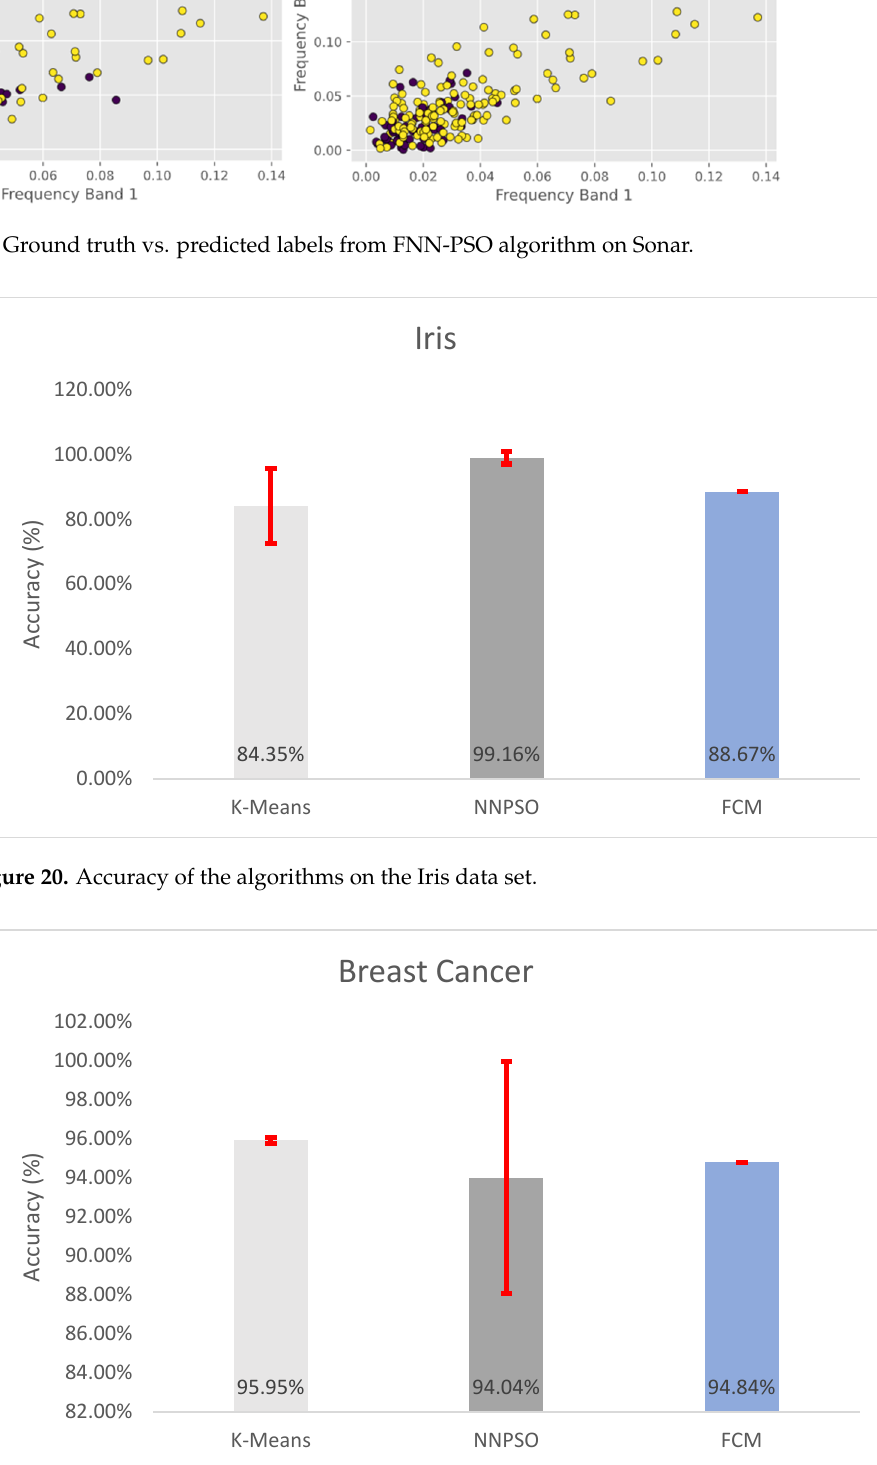
Figure 21. Accuracy of the algorithms on the Breast Cancer data set.